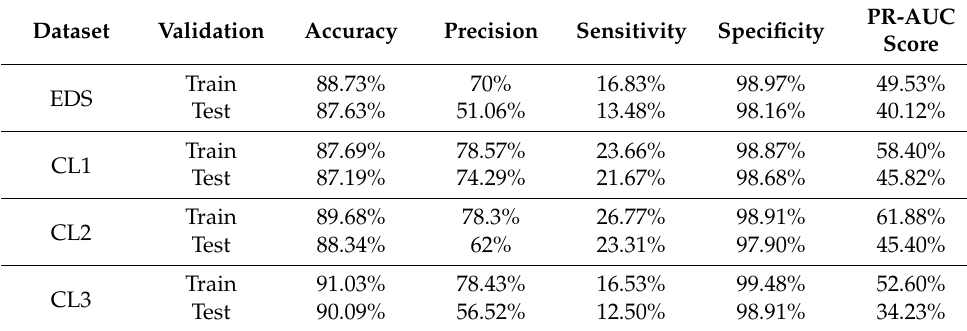
Table 6. Predicting performance